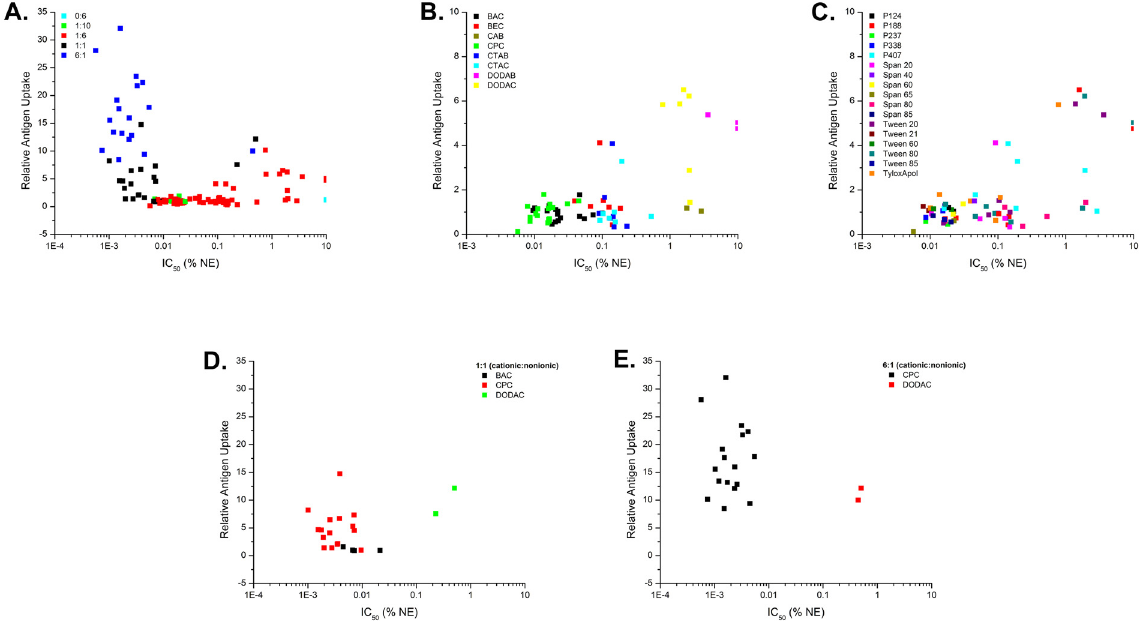
Fig 5. 2D scatter plots illustrating the relationship between cytotoxicity (IC50) and antigen uptake. (A) Data points grouped according to cationic: nonionic surfactant ratio for the entire library of NEs. (B) Data points grouped according to cationic surfactant type for the 1:6 NEs. (C) Data points grouped according to nonionic surfactant type for the 1:6 NEs. Data points grouped according to cationic surfactant type for (D) 1:1 and (E) 6:1 NEs.